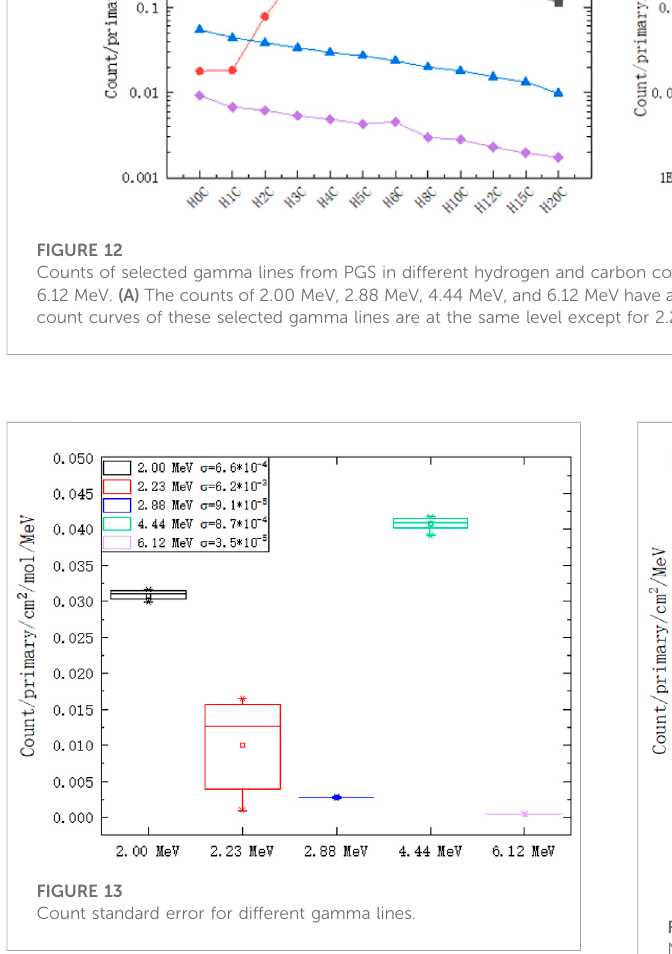
FIGURE 14 Nonlinear PG count per mol hydrogen in different